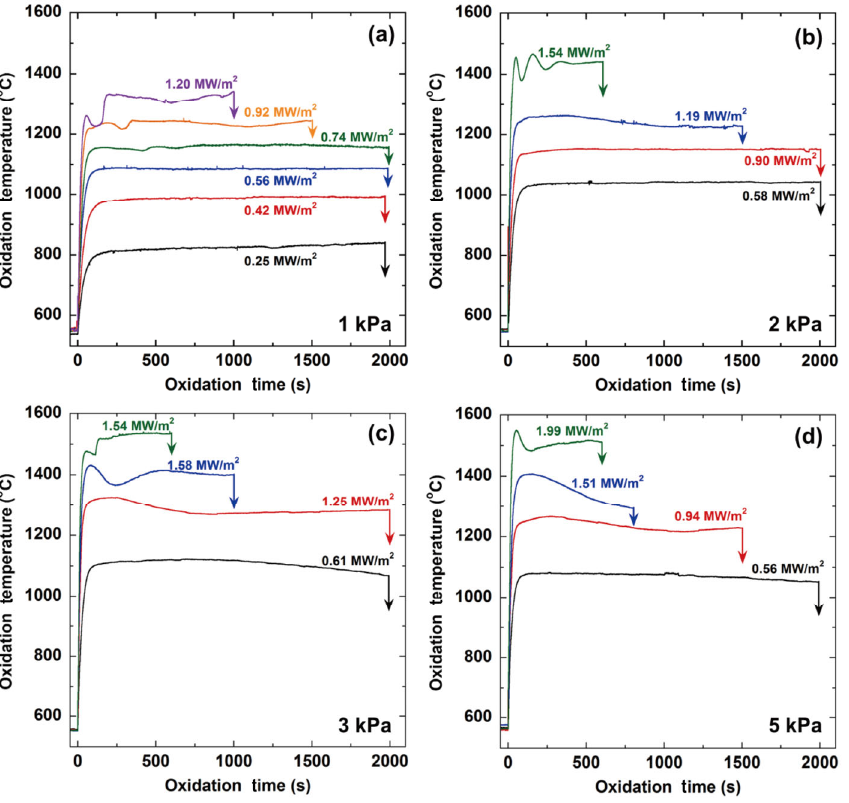
Fig. 2 Surface temperature evolution of C f /SiC cylinder flat specimens with oxidation temperature at varying heat fluxes and at